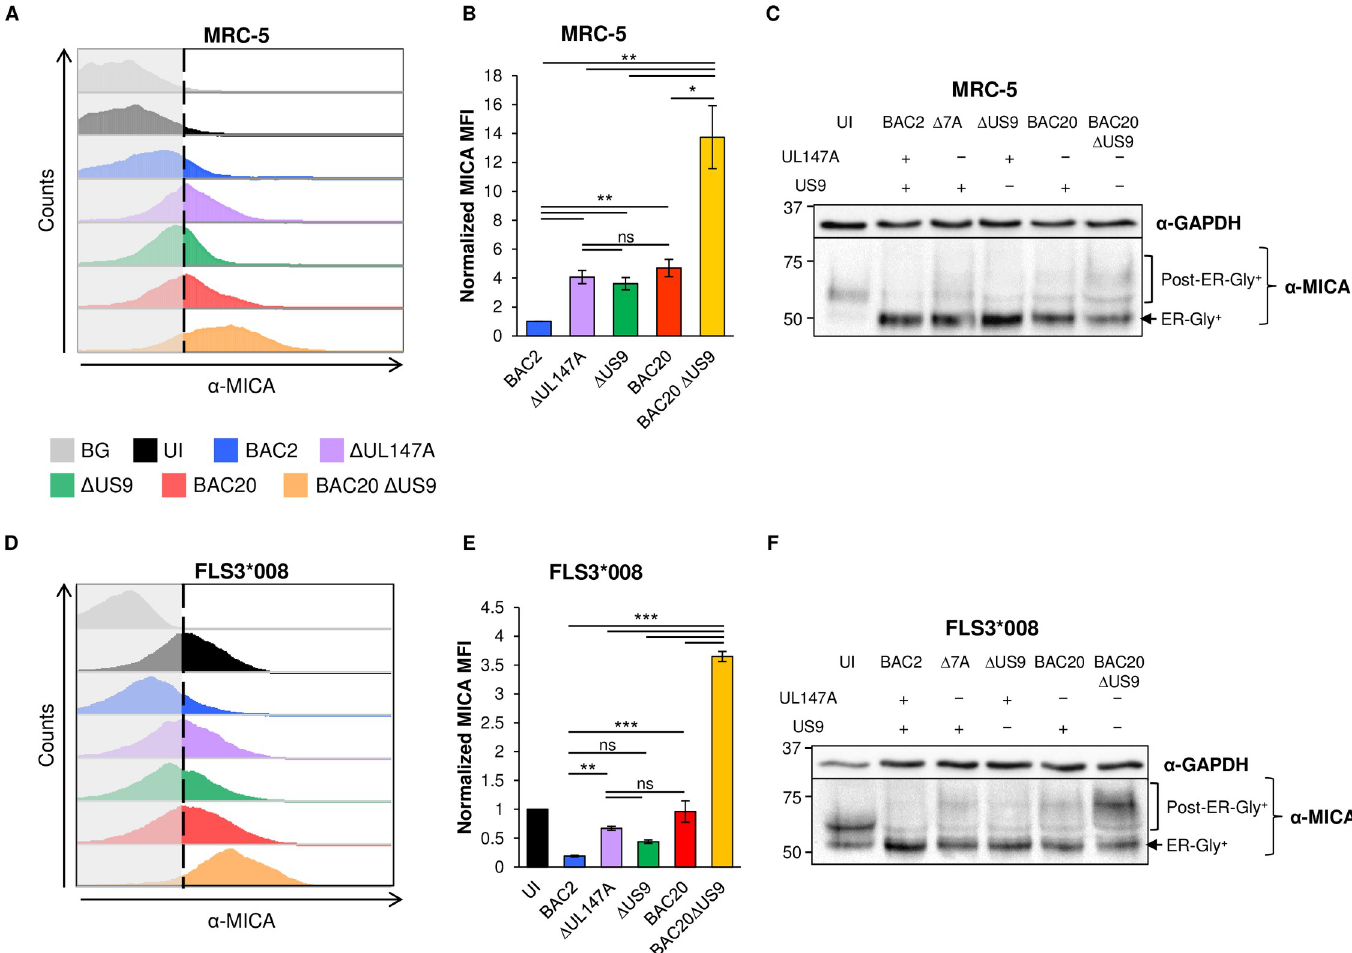
Fig 5. UL147A and US9 act additively to reduce MICA � 008 surface expression by intracellular sequestration. (A-C) MRC-5 HLFs (MICA � 008 homozygous) and (D-F) FLS3 � 008 (overexpressing MICA � 008) were either uninfected (UI) or infected with the indicated HCMV strains. Cells were harvested 72 hours post infection (hpi). (A, D) MICA surface expression was assayed by flow cytometry. Gray-filled histograms represent a secondary antibody staining of UI cells, all control stainings were similar to the ones shown. Representative of seven independent experiments for MRC-5 and three independent experiments for FLS3 � 008. (B, E) MICA median fluorescent intensity (MFI) values were quantified. Data show mean ± SEM. (B) Values were normalized to BAC2-infected cells. A repeated measures ANOVA with a Greenhouse-Geisser correction showed that MICA values differed significantly between infected cells [F (1.099,6.595) = 30.99, p = 0.0009]. (E) Values were normalized to uninfected cells and a one-way ANOVA was performed with a significant effect [F (10,14) = 100.9511, p = 4.8 � 10 − 8 ]. ANOVAs were followed by a post-hocTukey’s test. � p < 0.05, �� p < 0.01, ��� p < 0.001, ns not significant. (C, F) The same cells in (A, D) were lysed and a western blot was performed using anti-MICA antibody for detection of MICA and anti-GAPDH antibody as a loading control. Representative of two (C) or three (F) independent experiments. Presence or absence of UL147A and US9 in the different HCMV mutants is annotated. Full experimental data and statistics can be found in S1